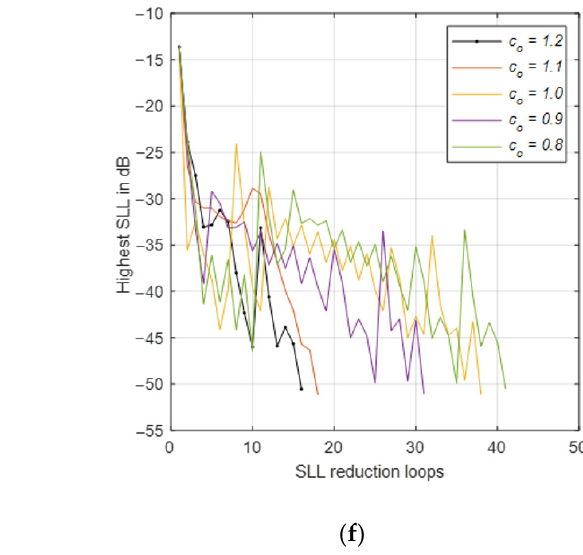
Figure 6. Convergence profile of the adaptive SSR learning curves at different initial damping factor with threshold damping factor of 0.7 and array size M of: ( a ) 16 elements, ( b ) 32 elements, ( c ) 64 elements, ( d ) 128 elements, ( e ) 256 elements, and ( f ) 512 elements.